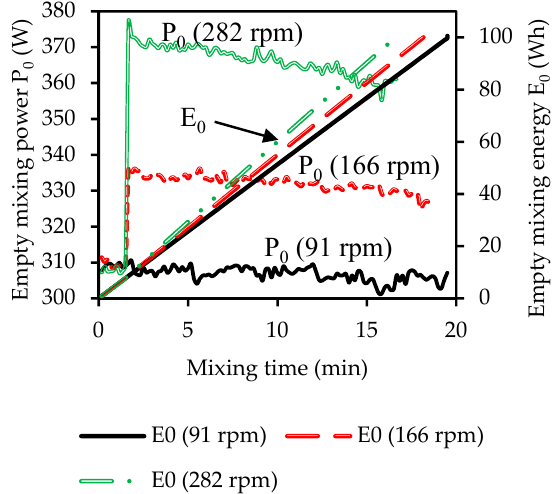
Figure 3. Variation in power consumption P 0 (t) and dissipated energy E 0 (t) for the empty running Omcan SP300AT mixer rotating at 91, 166, and 282 rpm with respect to running time t. The method for calculating E 0 using Equation (2) was validated by comparing calcu- lated and measured E 0 (at the first recording of 100 Wh on the wattmeter). Results are presented in Figure 4. The relative error in the E 0 calculation is less than 1% (i.e., 0.06%), which is assumed acceptable.